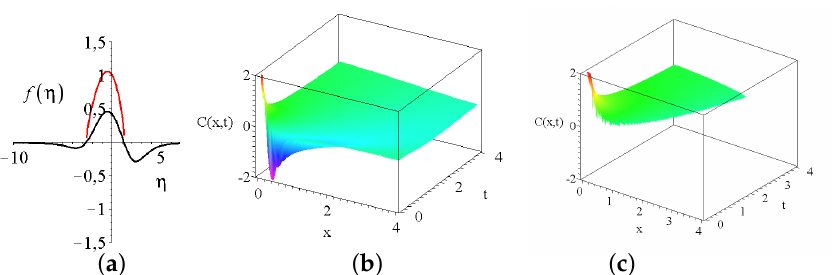
Figure 4. ( a ) Equation ( 39 ) the black and red lines are for a = 2, b = 1 and for a = 0, b = 1 case for D = c 1 = c 2 = 1, ( b ) the full solution C ( x , t ) for a = 2, b = 1 , ( c ) the full solution C ( x , t ) for a = 0, b = 1